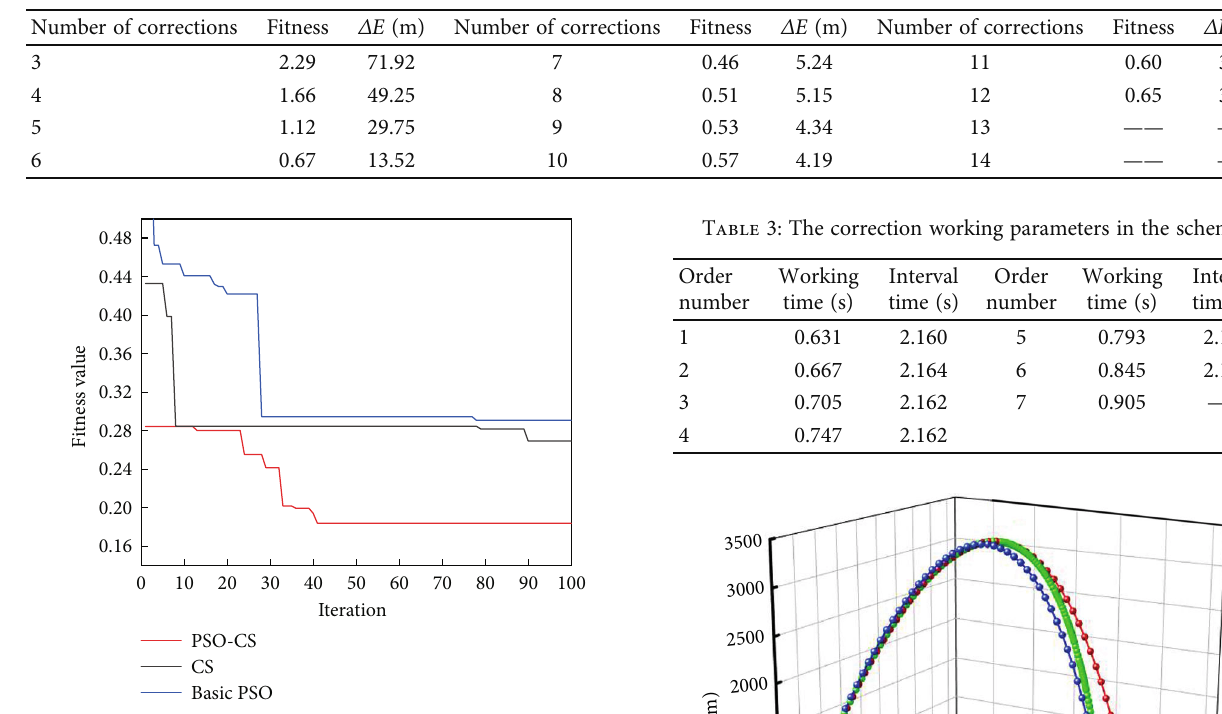
Table 1: Calculation results of di ff erent swarms.